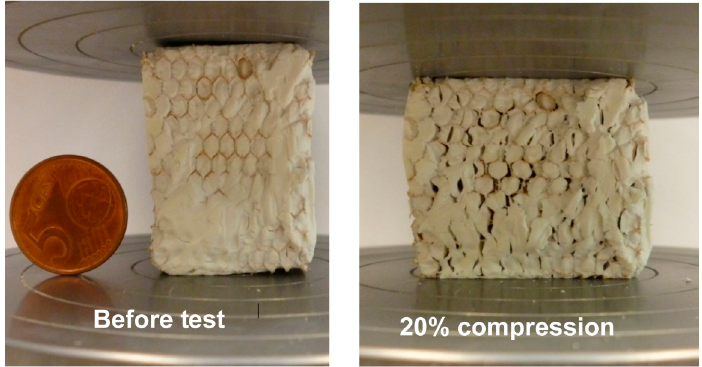
Figure 17. Compression test of SA2 with C1-3.2-29 honeycombs in-plane. Several cracks and holes arose during compression.